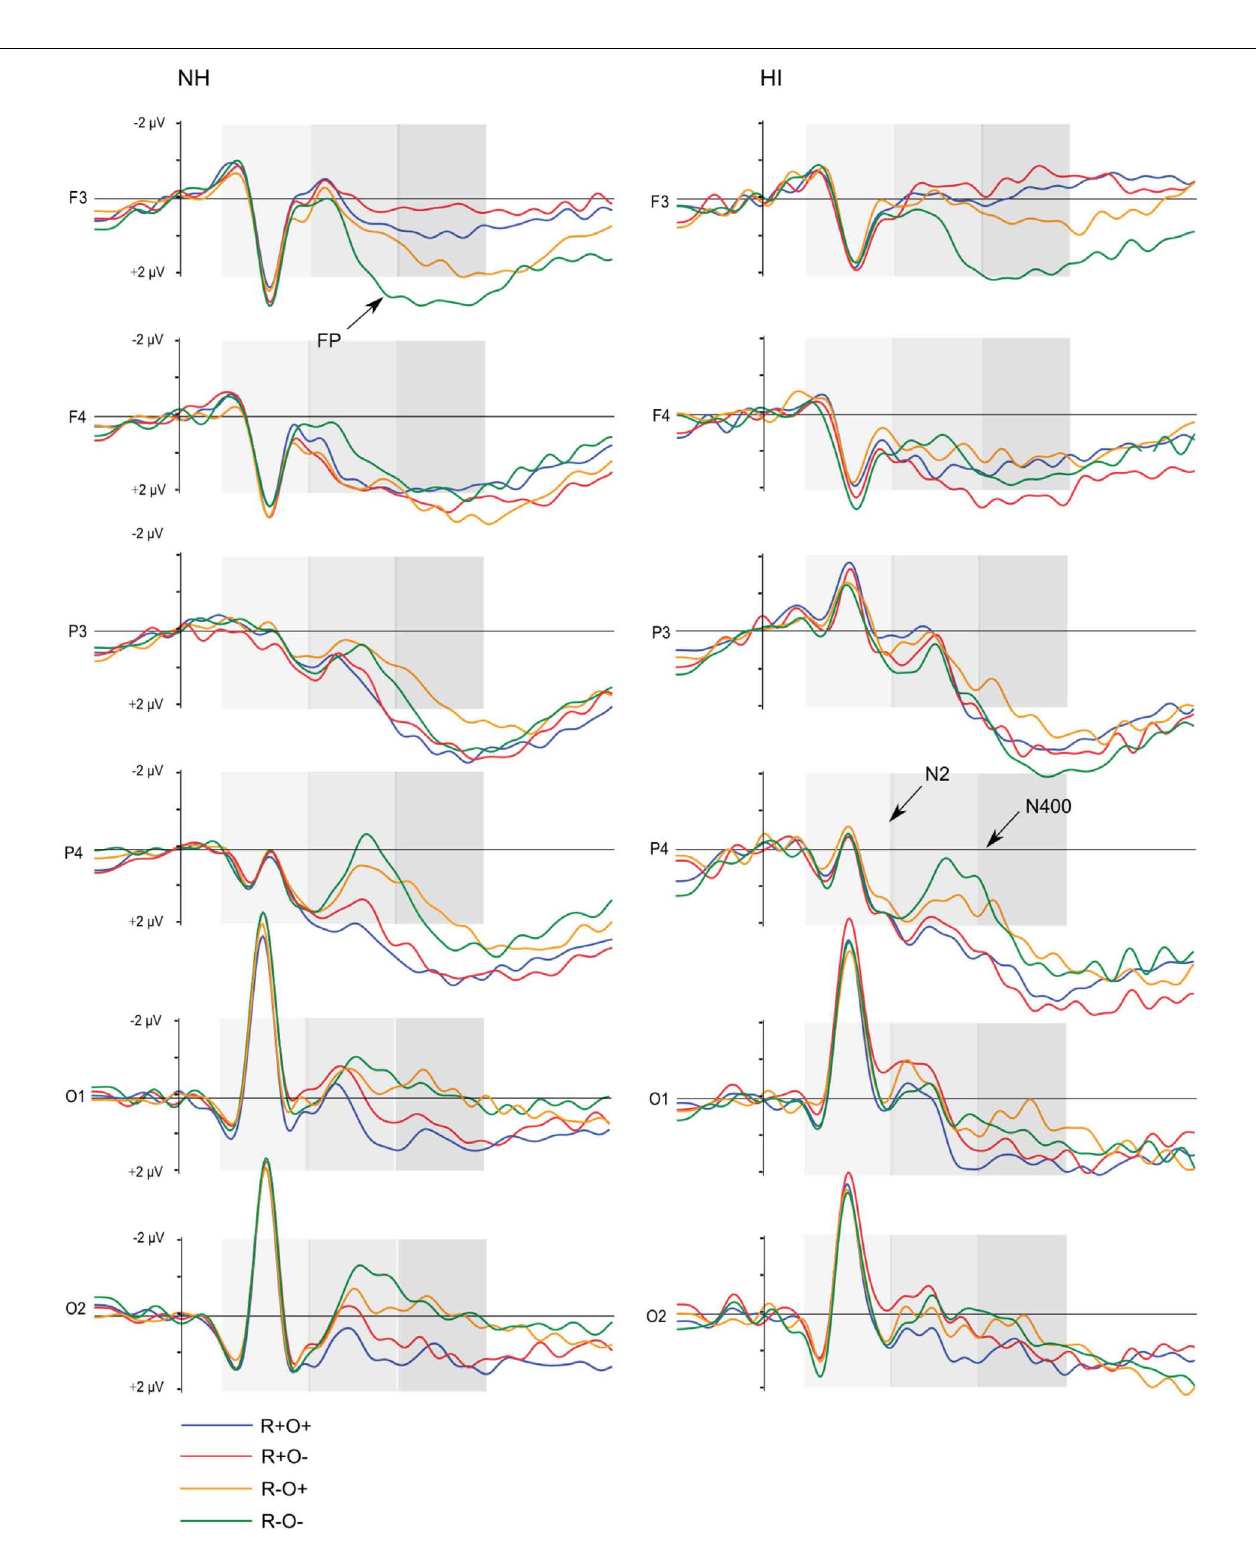
FIGURE 5 | Grand average ERP waveforms elicited by R + O + , R + O − , R − O + , and R − O − target words in each group, long ISI condition. The shaded areas mark the 100–300, 300–500, and 500–700ms time-windows, respectively.